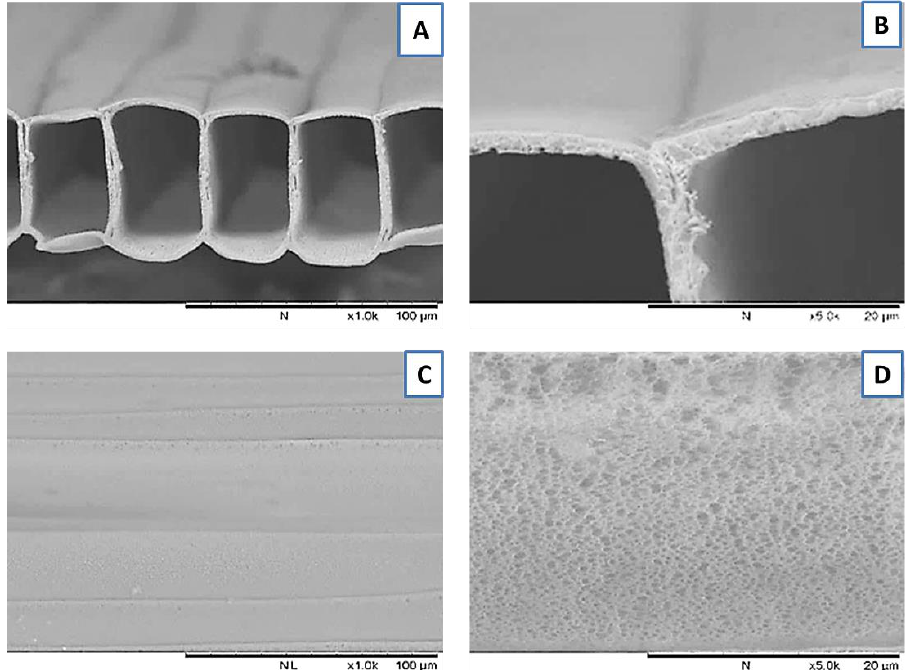
Figure 1. SEM images of electrospun PLGA MTAM ( A ) Transverse section; ( B ) Zoomed-in view lumen wall depicting highly porous structure; ( C ) Top view and; ( D ) Zoomed-in view of top view depicting pores.